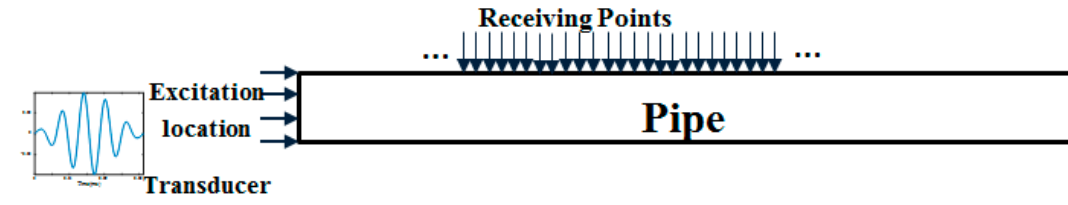
Figure 5. Collecting guided wave signals at every 1 mm along the pipe axis.